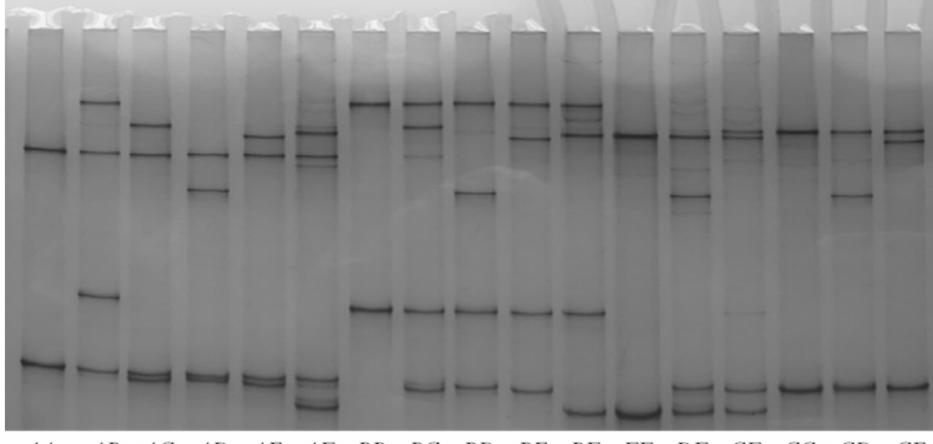
Figure 1. Polymorphism of caprine KRTAP1-2 identified using PCR-SSCP analysis. Six variants ( A – F ) represented by six unique banding patterns were found in arrangements that appeared to correspond to either heterozygous or homozygous